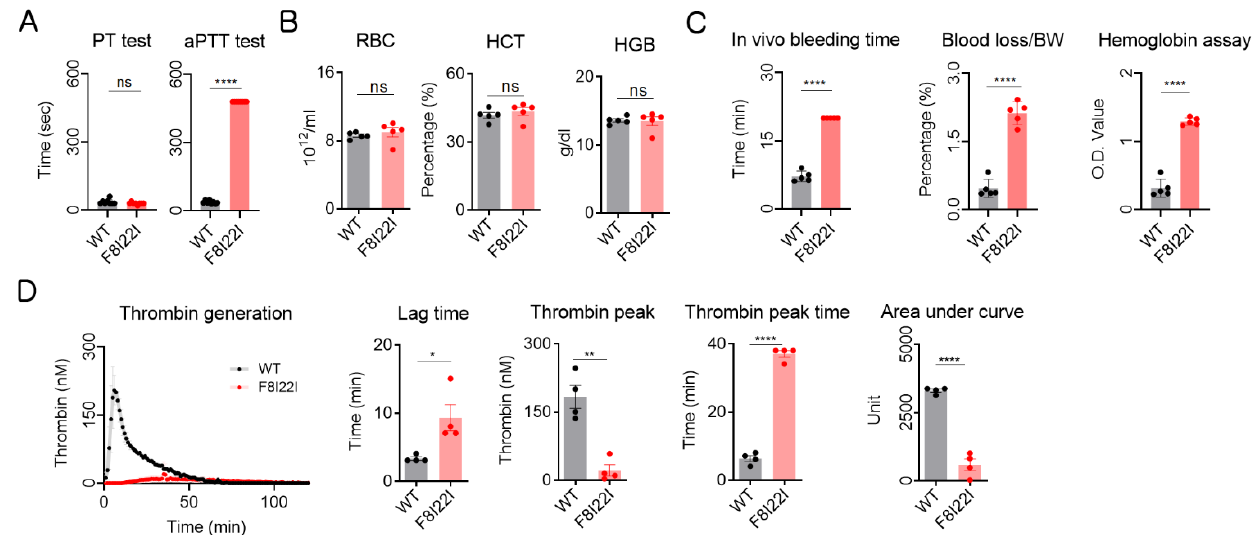
Figure 3. Hemophilia diagnosis using lab experiment in F8I22I. ( A ) Coagulation activity was assessed by partial thromboplastin time (PT), activated partial thromboplastin time (aPTT) (WT: n = 5, F8I22I: n =5). ( B ) Complete blood count (CBC) was conducted to analyze hemoglobin composition (WT: n = 5, F8I22I: n = 5). ( C ) In vivo bleeding analysis for confirmation of coagulation disorder (WT: n = 5, F8I22I: n = 5). ( D ) Thrombin generation potential was analyzed by the calibrated automated thrombogram using platelet-rich plasma (WT: n = 4, F8I22I: n = 4). The manufacture supplying software calculated lag time, peak height, and peak time. Each dot represents data from an individual mouse and is presented as mean ± SEM. ns : not significant, * : p < 0.05, ** : p < 0.01, **** : p < 0.0001.